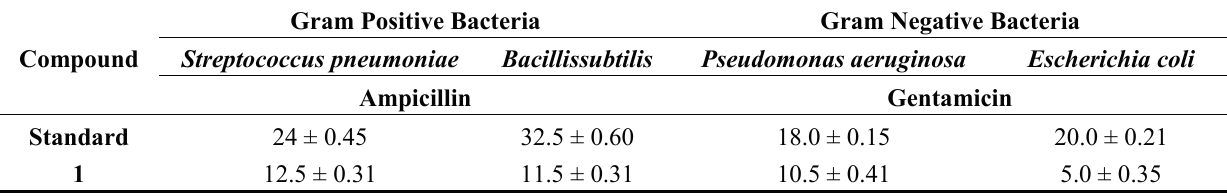
Table 6. Antibacterial activity of the synthesized compound 1 (Zone of inhibition; diameter in mm).